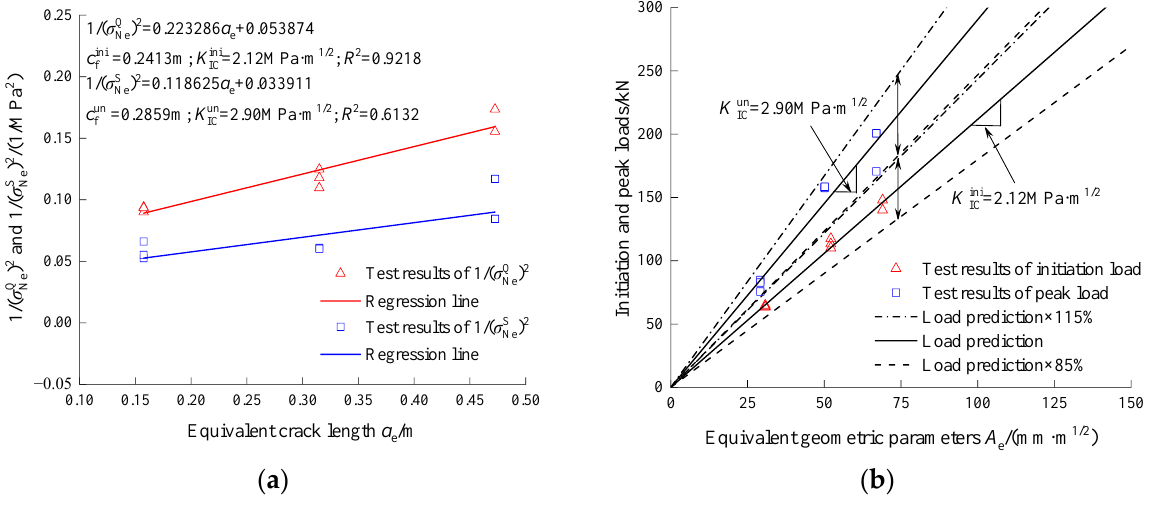
. The calculation results show that the predicted re- sults of initiation and peak loads based on the size effect model are close to the test results.